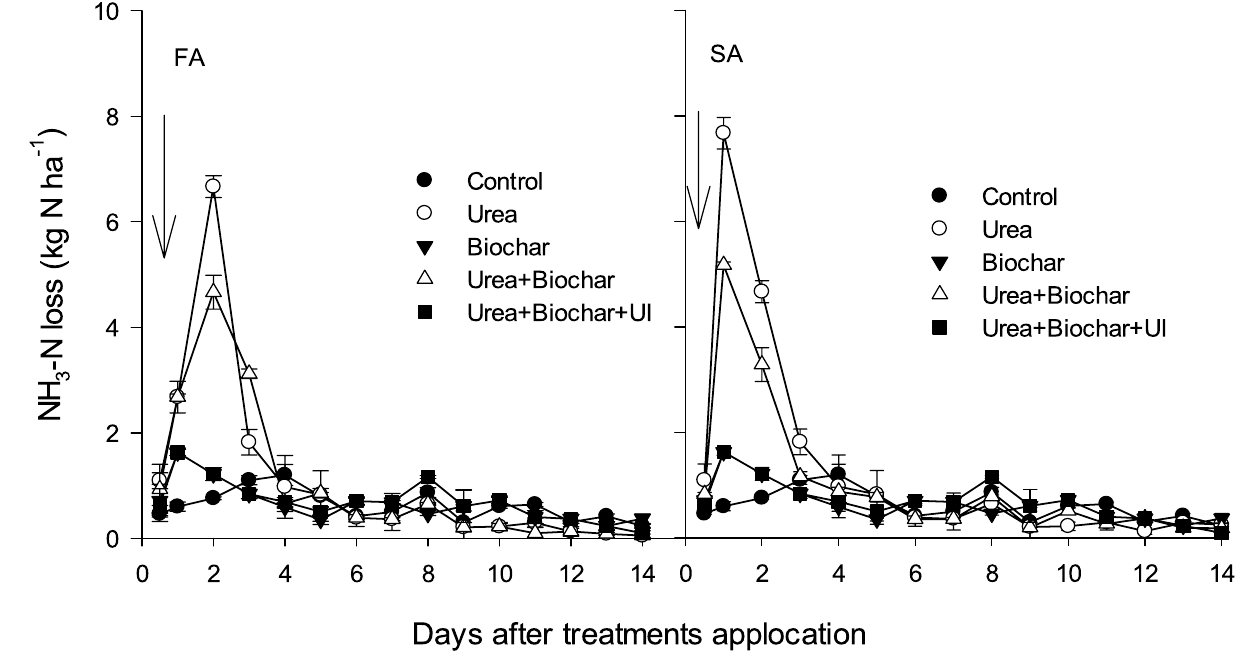
Figure 2. Soil NH 3 Fluxes as influenced by nitrogen application with and without biochar and/or urease inhibitor. Bars on means represent SE for n = 4. The arrows show time of N application. Where, FA (First dose application) and SA (Second dose application).